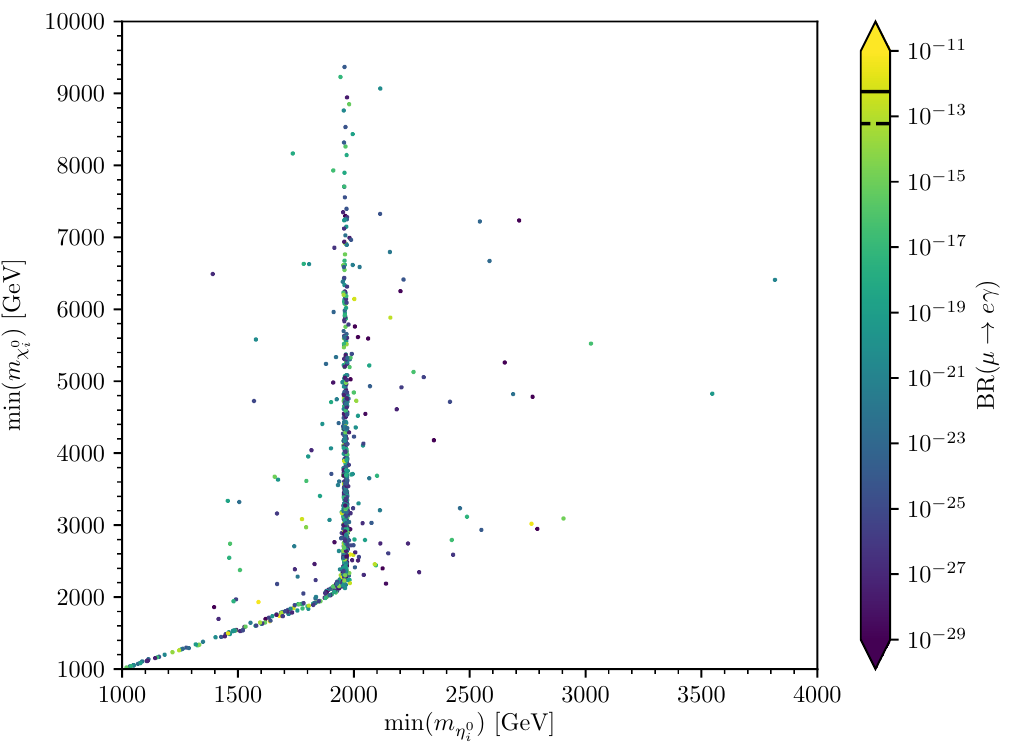
Figure 11 . The lightest neutral fermion vs. the lightest neutral scalar mass for viable models with triplet scalar DM. Also shown is the branching ratio for the LFV process (cid:22) line) and future (dashed line) exclusion limits [41,